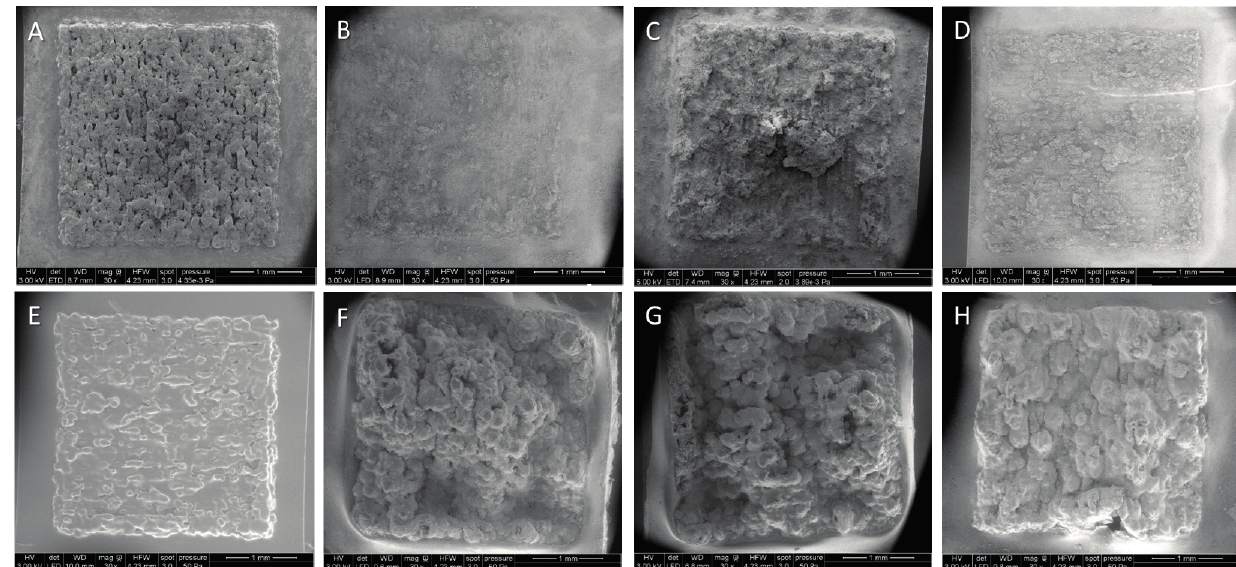
Figure 2. Representative ESEM micrographs of non-coated ( A – D ) and polycaprolactone (PCL)-coated ( E – H ) magnesium structures after different corrosion time intervals ( A , E : 0 days; B , F : 1 day; C , G : 3 days; D , H : 21 days).